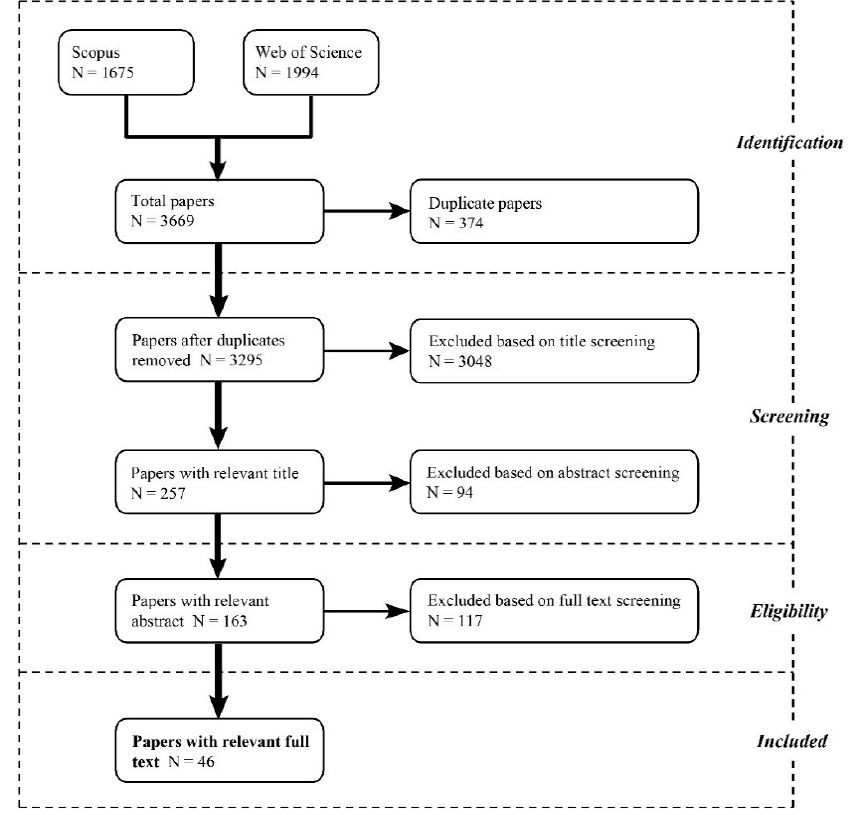
Figure 1. Literature search process based on the PRISMA flow diagram.